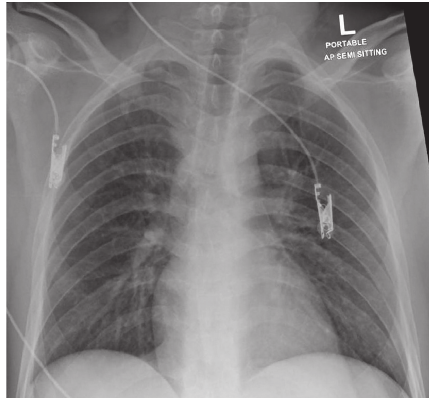
Figure 1: Chest X-ray on admission shows no lung